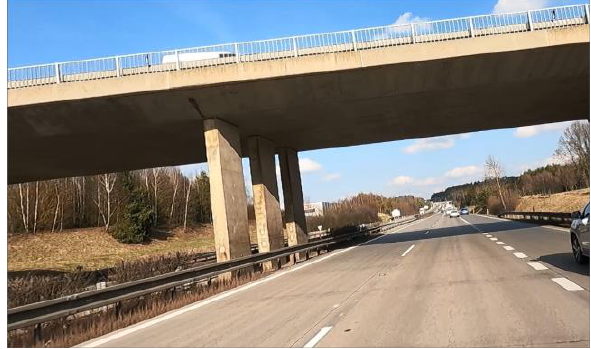
Figure 2 . Identified insufficient levels of restraint during RSA on the D5 motorway (Prague – Nuremberg)